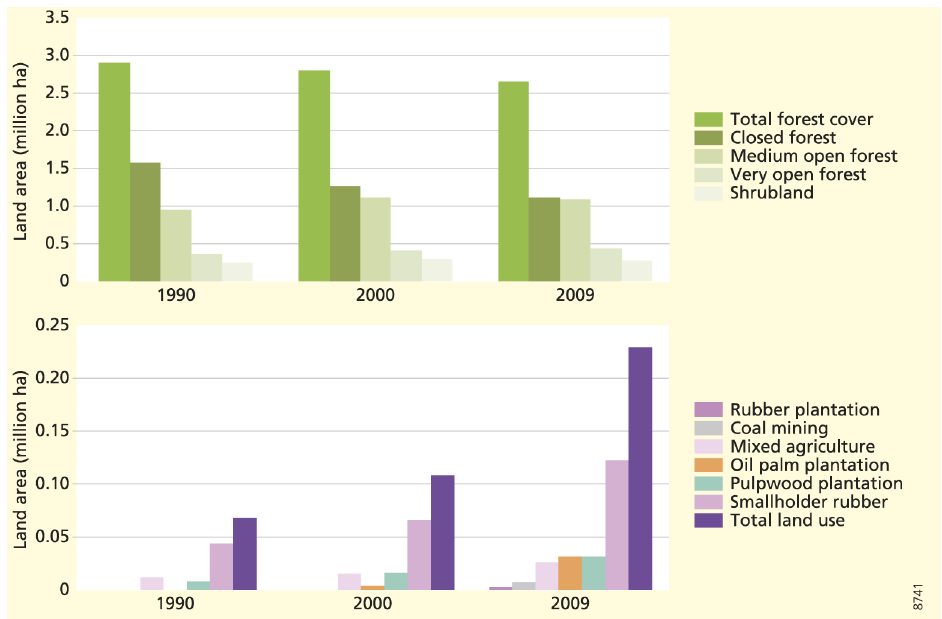
Figure 2. Land cover change in the West Kutai and Mahakam Ulu districts between 1990 and 2009, based on quantitative analyses of the land cover maps [43]. Change in natural land cover types (top graph), namely ‘total forest cover’ (summation of the three forest cover types), the forest types differentiated based on canopy closure and shrubland (grassland is excluded since it entails a relatively small land area); and change in the anthropogenic land uses (bottom graph), namely ‘total land use’ (summation of all anthropogenic land uses, excluding gold mining and settlements) and the six land uses differentiated by type. ‘Total land use’ is calculated as the sum of the six anthropogenic land use classes and shows an increase from 0.07 Mha in 1990 to 0.22 Mha in 2009. This increase of anthropogenic land use is, in most part, at the expense of the decrease of ‘total forest cover’ from roughly 2.9 Mha in 1990 to 2.7 Mha in 2009.